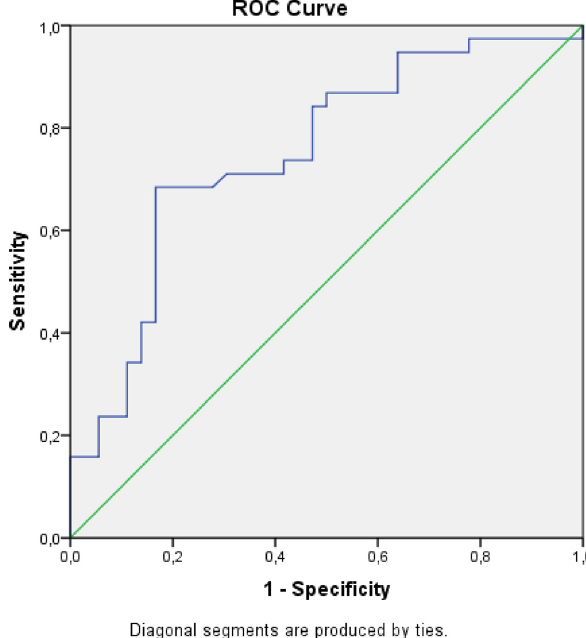
Figure 3: Area under the ROC curve (AUC) was 0.75 (95% CI: 0.638 – 0.863) to predict